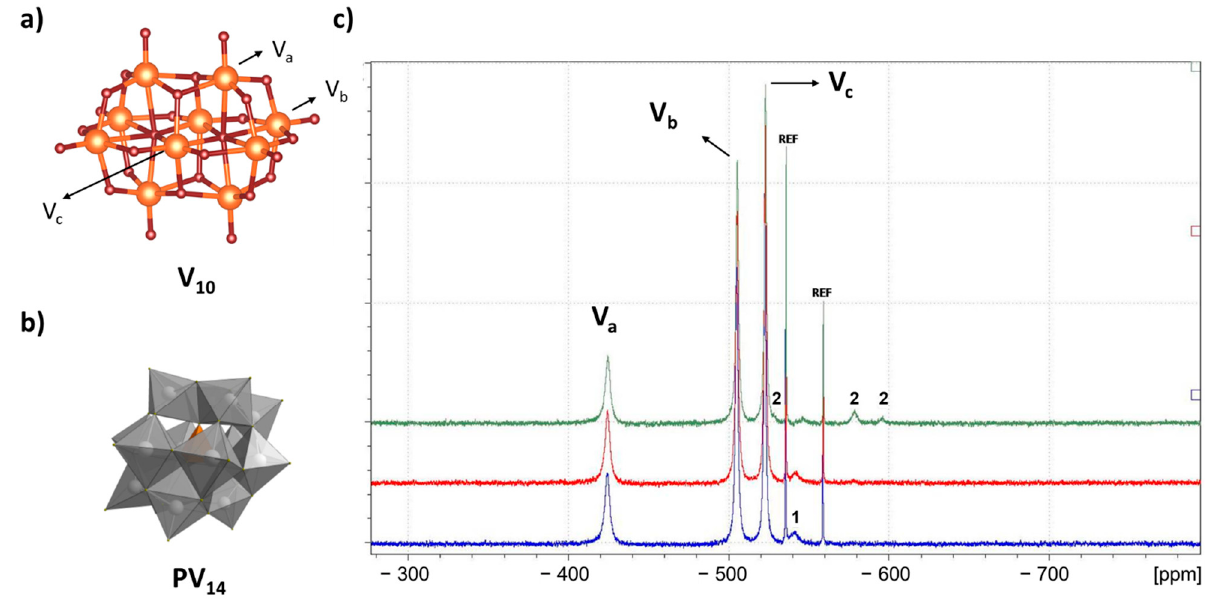
Figure 4. Schematic representation of ( a ) decavanadate (V 10 ) and ( b ) trans-bicapped Keggin tetradecavanadophosphate species [H x PV 14 O 42 ] (9 − x) − (PV 14 ). ( c ) 51 V-NMR recorded spectra immediately after mixing (blue) and after 30 min (red) and 110 min (green) during hydrolysis of 20 mM ATP in the presence of 200 mM Na 3 VO 4 and 600 mM NaCl at pH 2.0 and 37 °C show that two new vanadate species appear (marked as 1 and 2) in the reaction mixture. Spectra recorded at 25 °C and 50 °C were very similar to the one presented. The sharp resonances assigned with ‘REF’ belong to the external reference.